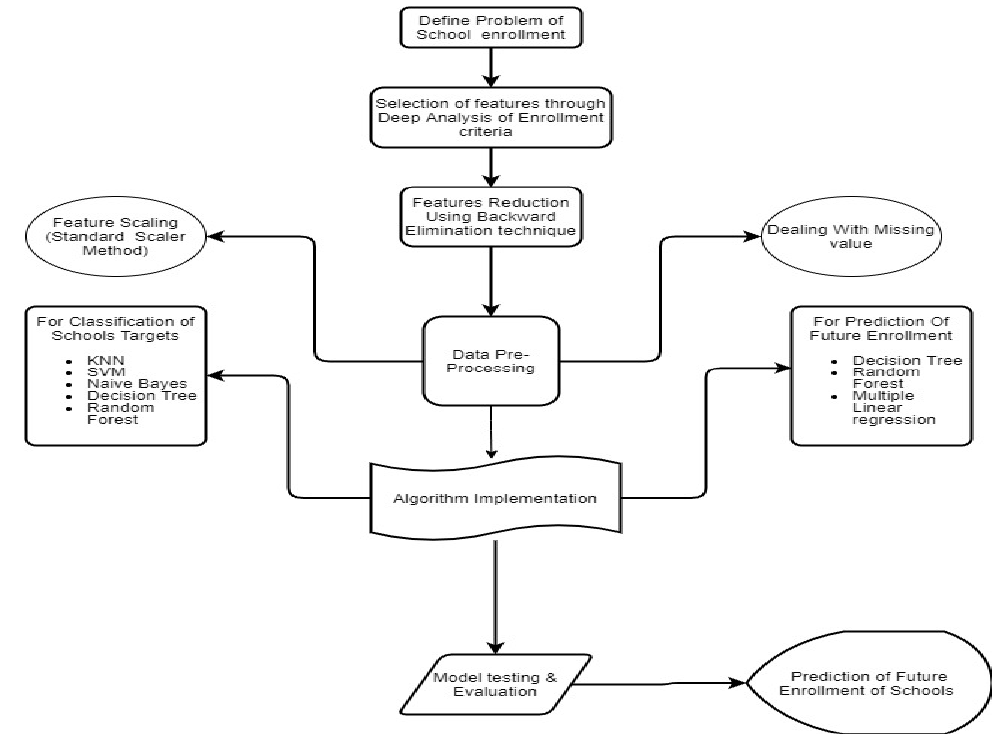
Figure 2. Workflow of research.